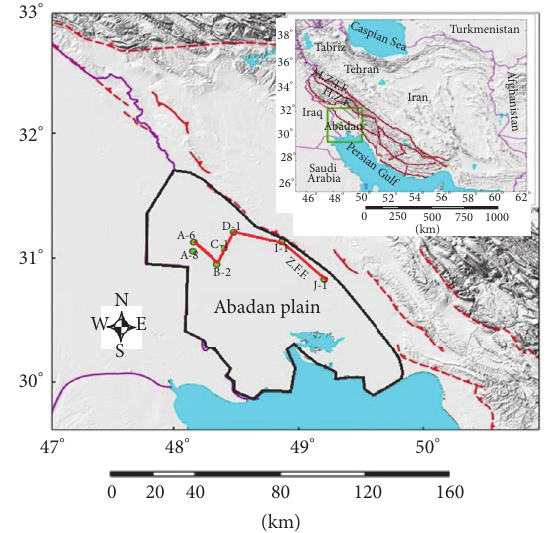
Figure 1: The location of studied wells on the map of the Abadan Plain Basin and contiguous area. The arbitrary line between wells A- 6, B-2, D-1, I-1, and J-1 corresponds to the stratigraphic correlation in Figure